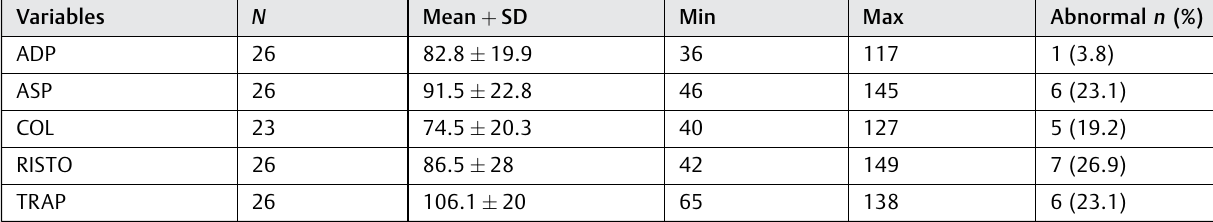
Table 2 Platelet function test ’ s description